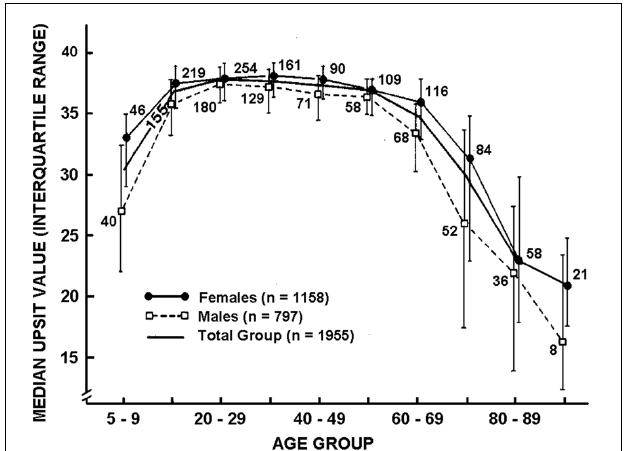
FIGURE 4 | Scores on the University of Pennsylvania Smell Identification Test (UPSIT) as a function of age and gender in a large heterogeneous group of subjects. Numbers by data points indicate sample sizes. From Doty et al. (1984a), with permission. Copyright©1984, American Association for the Advancement of Science.